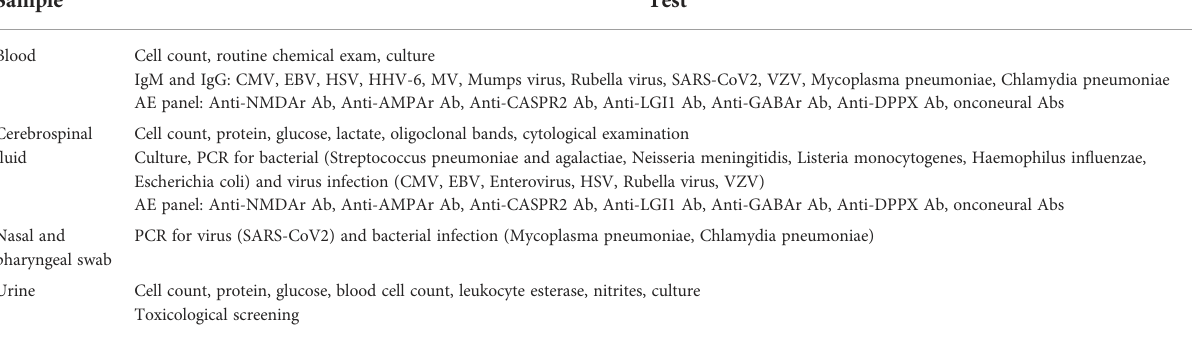
TABLE 1 Test performed on blood, cerebrospinal fl uid, nasopharyngeal, and urine samples. Sample Test